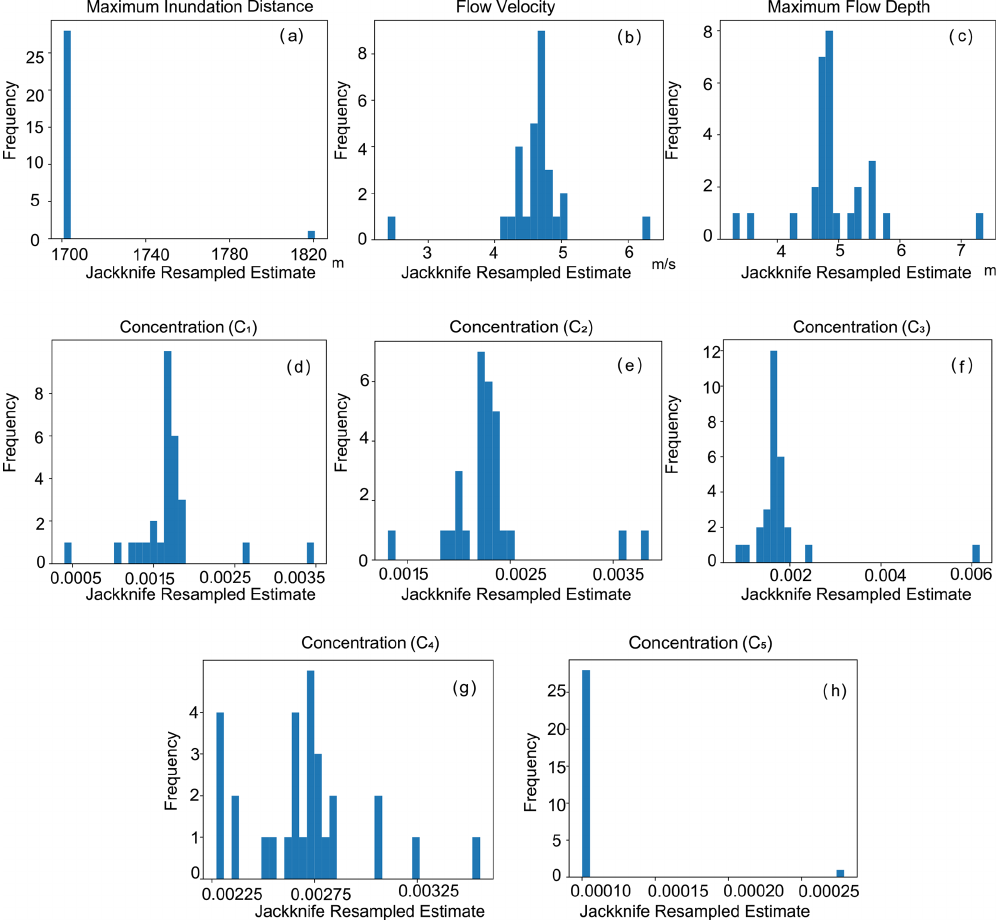
Figure 12. Jackknife estimates for the results predicted by the inverse model at the 1700m sampling window, used to determine the uncer- tainty of the